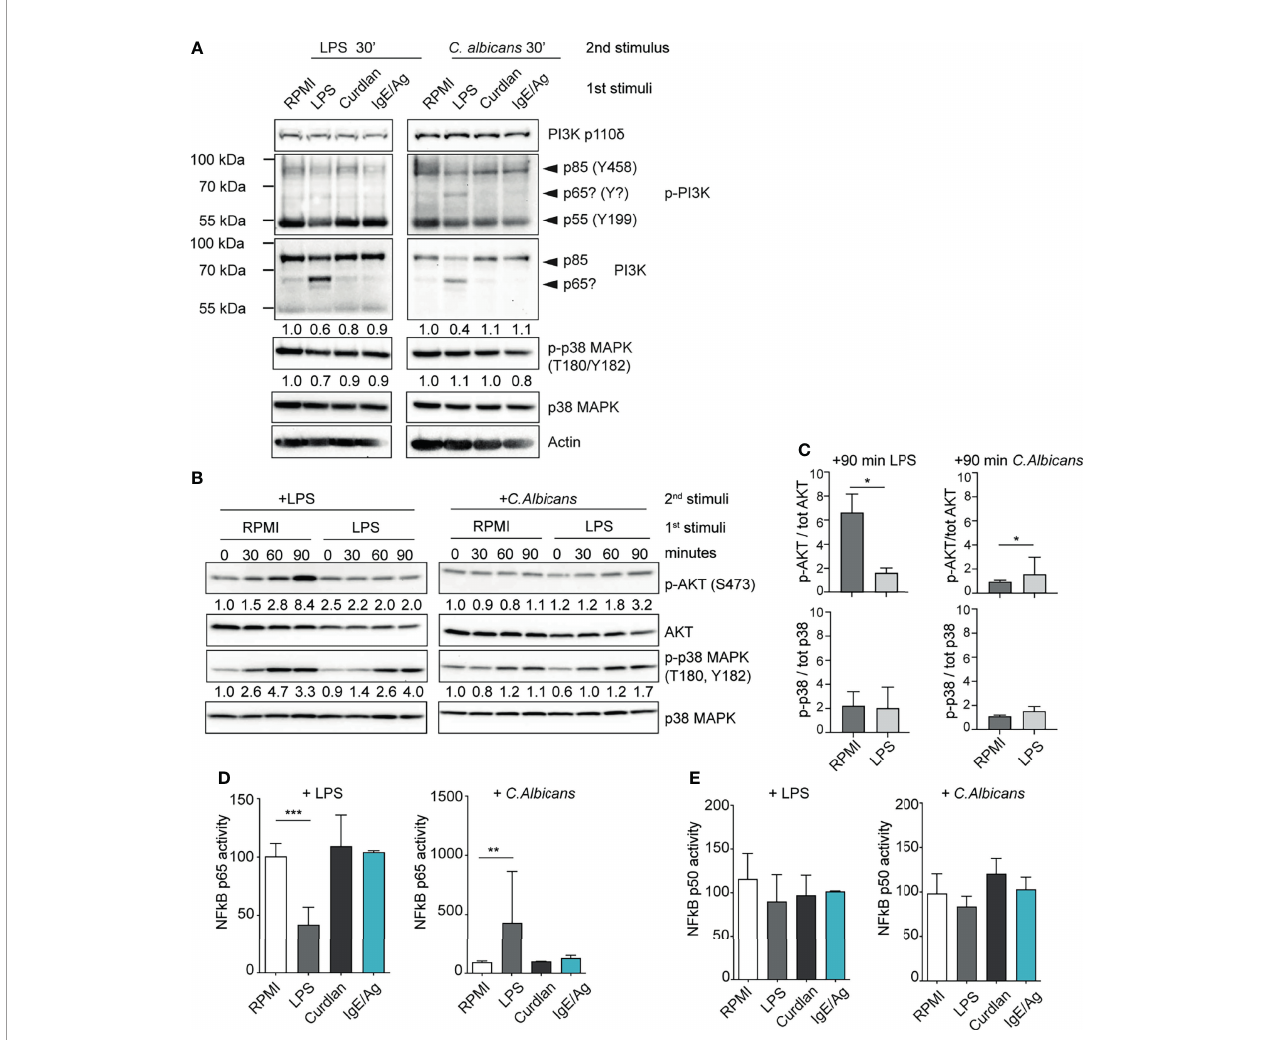
FIGURE 4 | LPS-primed MCs differently activate the PI3K-AKT pathway. (A) Western Blot (WB) analysis of PI3K subunits and of phosphorylated p38 in differently primed-BMMC restimulated for 30 minutes with LPS or live C. Albicans (MOI=1). Numbers indicate the results of densitometric analyses calculated over endogenous protein expression. (B) Time-course WB analysis of phosphor Akt and phospho p38 in LPS primed-BMMC restimulated with LPS or live C. Albicans (MOI=1). Numbers indicate the results of densitometric analyses calculated over endogenous protein expression normalized versus t=0. (C) Mean + SD of densitometric analysis of n=3 independent experiments are reported. Statistical analyses were performed with paired Student t-test (*=p<0,05). NF-kB p65 (D) and p50 (E) activity in LPS primed BMMC was determined after 30 minutes form addition of the second stimuli. Results were expressed as fold percentages over control (RPMI). Mean + SD of n=3 independent experiments are reported. Statistical analysis were performed with one-way Anova with Dunnet correction (*p < 0,05 **p < 0,01; ***p <